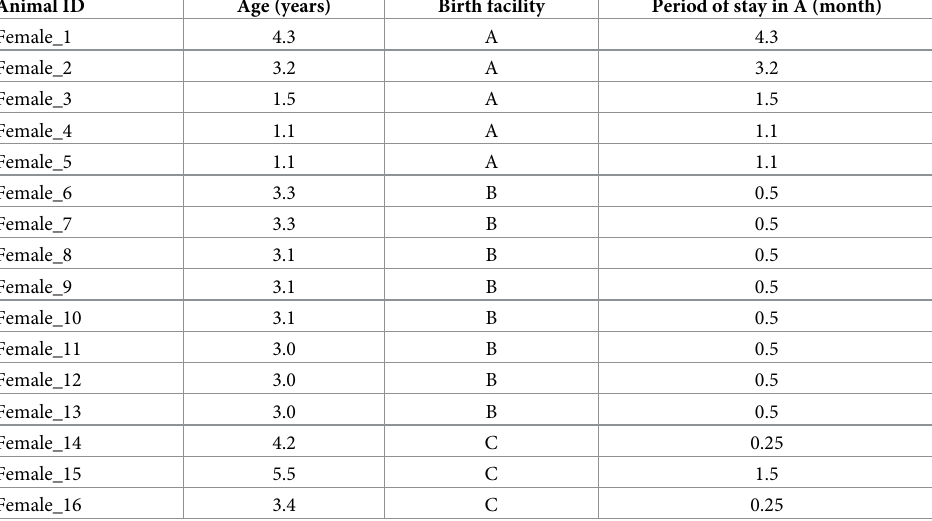
Table 1. List of healthy individuals. Animal ID Age